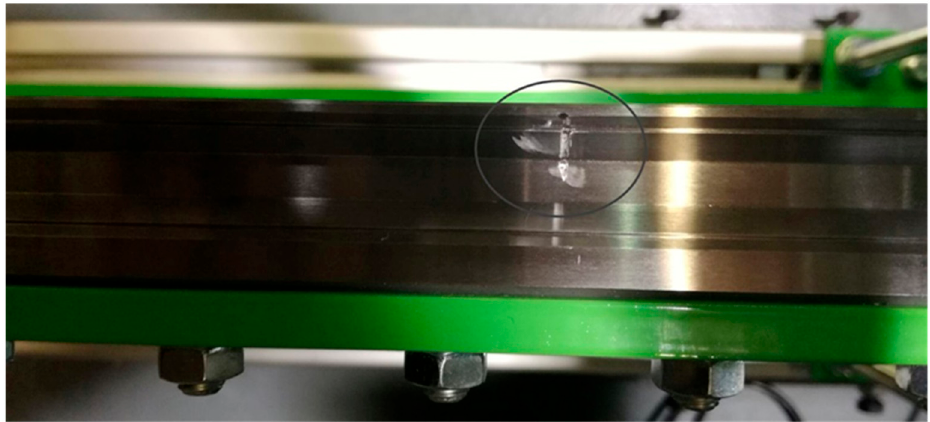
Figure 7. The simulated damage of the guiding profile.